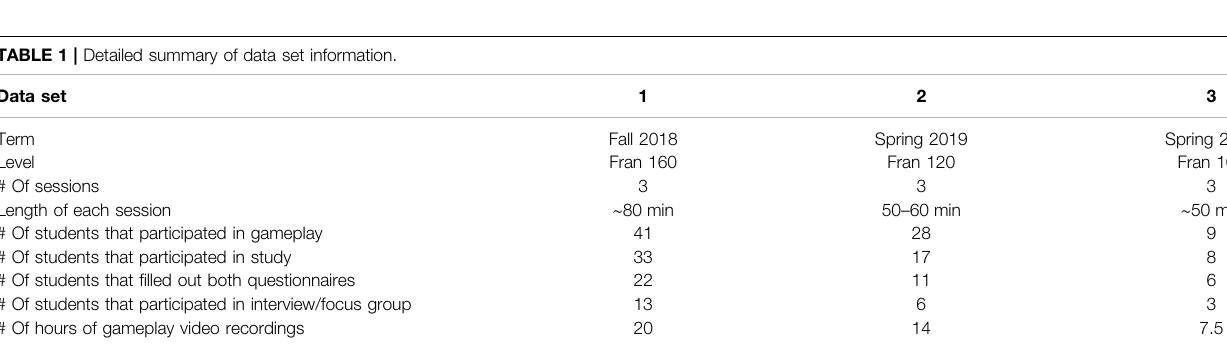
TABLE 1 | Detailed summary of data set